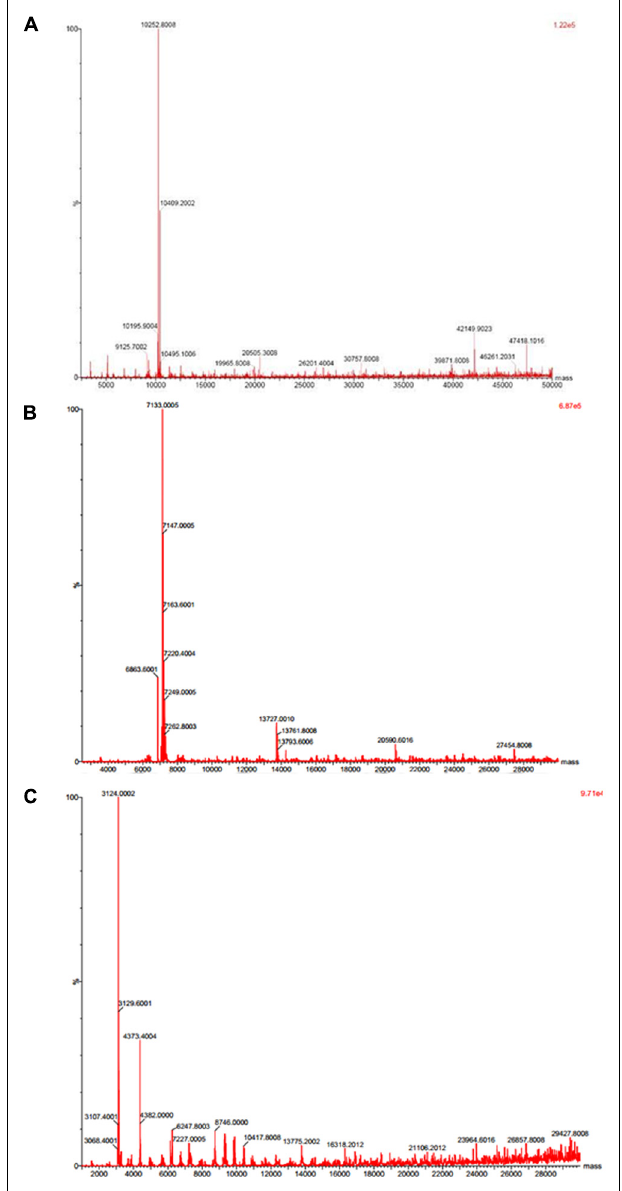
FIGURE 2 | Mass spectrometry analysis of JcTI-I. (A) Native JcTI-I; (B,C) JcTI-I previously reduced and alkylated with DTT and iodoacetamide,